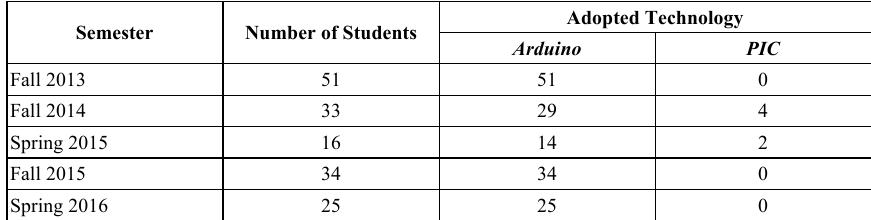
Table 1. Breakdown of used technology in the course project.